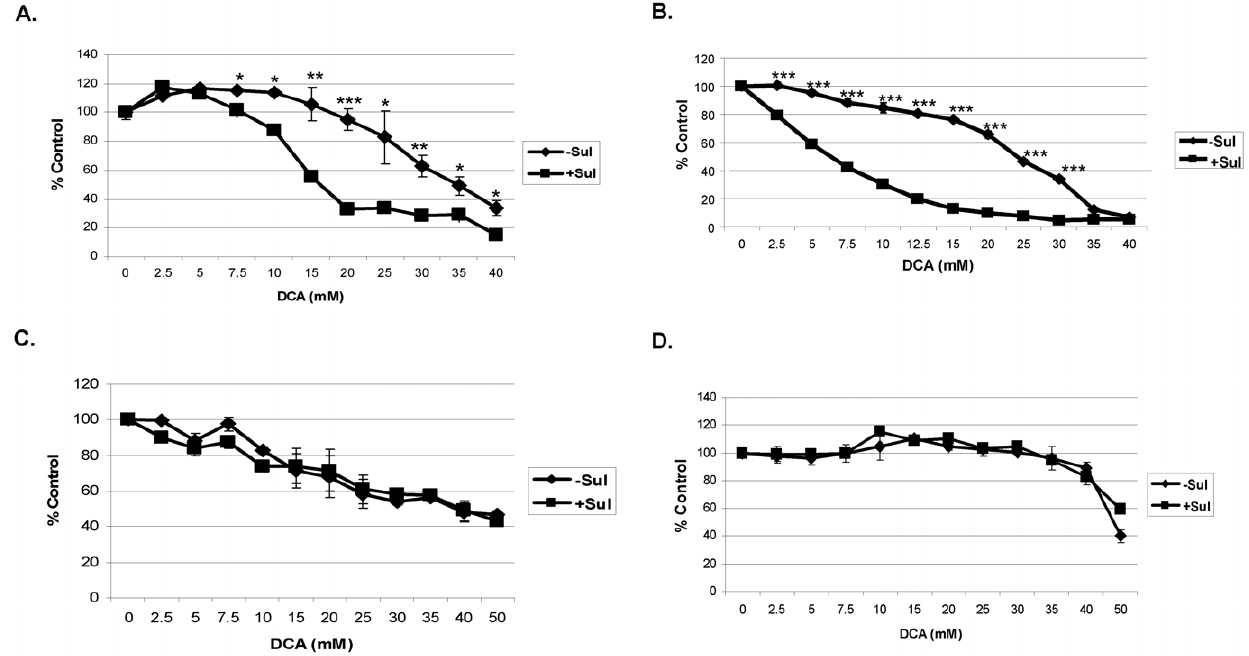
Figure 1. Sulindac in combination with DCA selectively kills cancer cells. The A549 and SCC25 cancer cells, normal lung cells, and human epidermal keratinocytes were treated with the indicated concentrations of DCA in the presence or absence of sulindac (Sul) for 48 hours. The cell viability was monitored by MTS assay as mentioned in the Methods. The cell viability is expressed as % of control (cells not treated with sulindac). Error bars are standard error of the mean (SEM) expressed as % of the mean value of quadruplicates from a representative experiment. Cell viabilities are illustrated for A549 cancer cells (A), SCC25 cancer cells (B), normal lung cells (C) and normal human epidermal keratinocytes (D). ¤ , -Sul; & , + Sul. * p , 0.05, ** p , 0.005, ***p ,